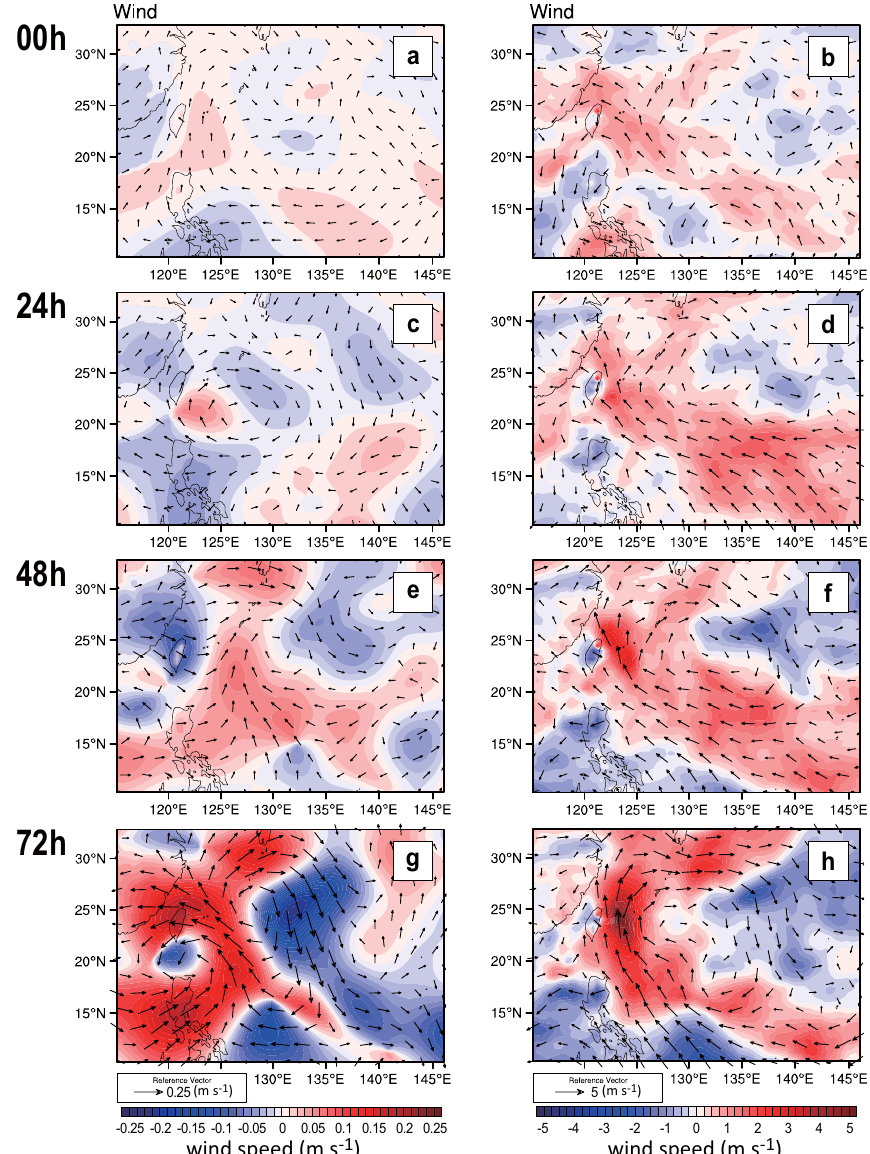
Figure 9. Mean differences of wind speed (shading) and wind vectors at 700hPa between PWG and PNG (left column), and between ECMWF and PNG (right column) at forecast time from 00 to